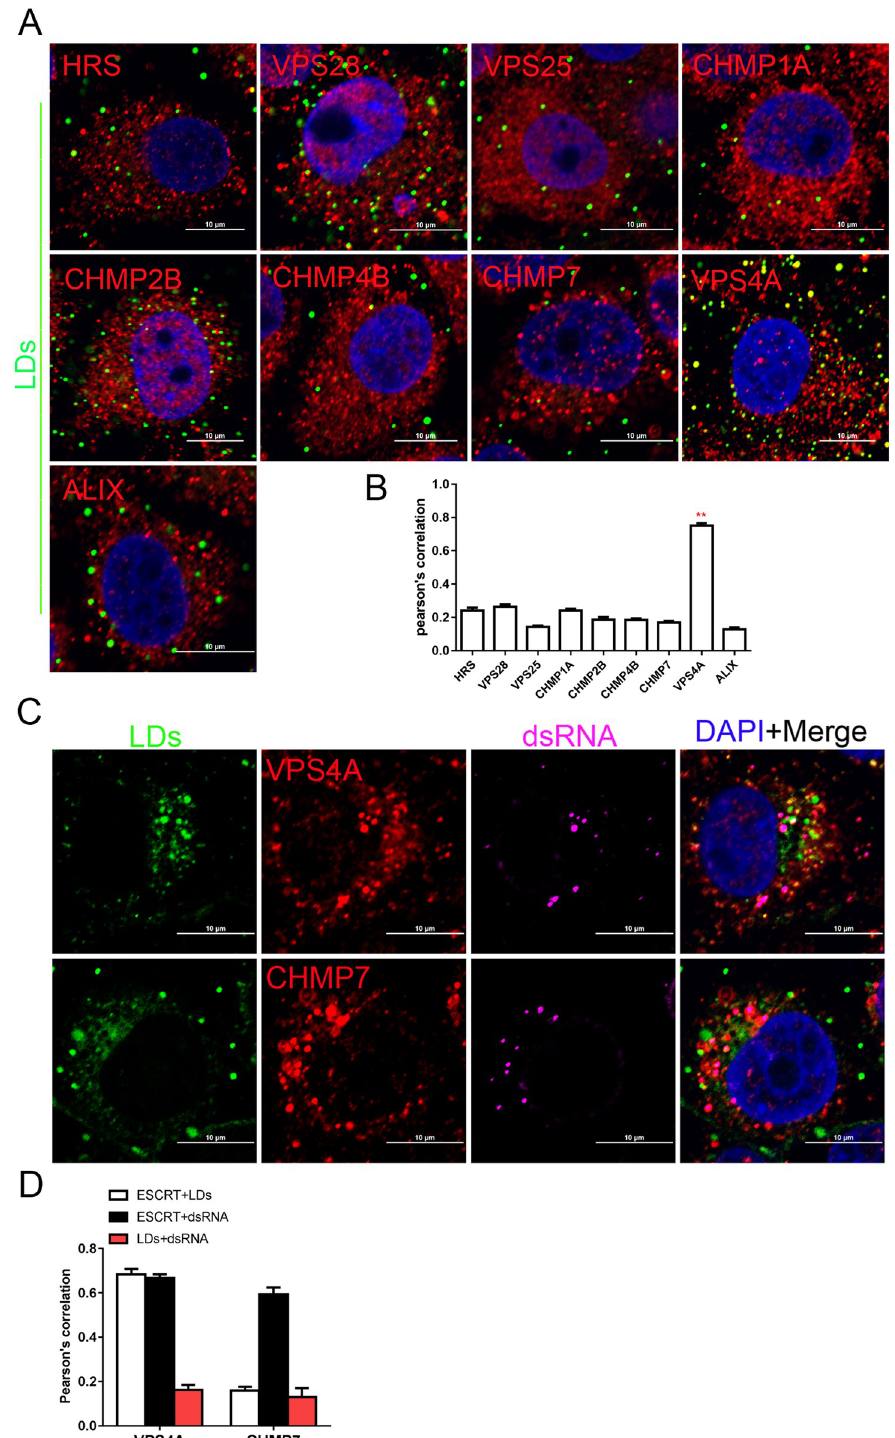
Fig 9. VPS4A protein is closely related to lipid droplets (LDs). (A) PK-15 cells were infected with CSFV (MOI = 1) for 24 hpi, then fixed and subjected to immunofluorescent by using rabbit anti-ESCRTs antibody (red) and dyeing with BODIPY (green). The nuclei were stained with DAPI. Bars = 10 μ m. These data are representative of three independent experiments. (B) The colocalization analysis of ESCRT subunits and LDs was expressed as Pearson’s correlation coefficient. Results are represented as the mean + SD of data from three independent experiments. ��